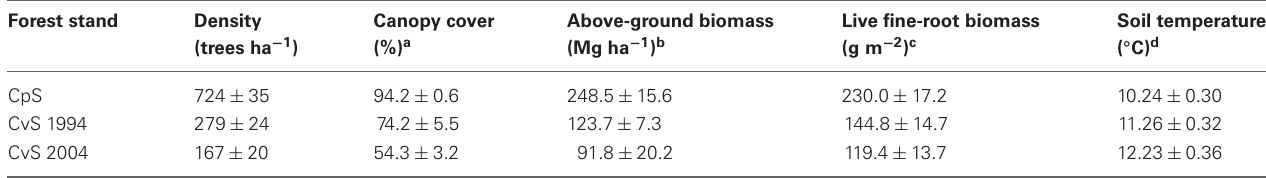
Data shown are means ± S.E. dbh, diameter at breast height. a Canopy cover values are the mean of 10 replicates. b